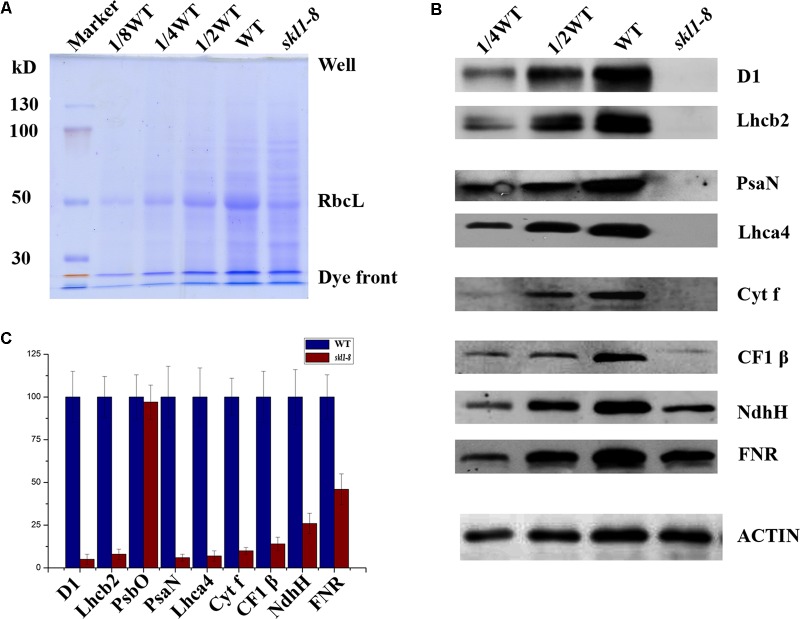
Accumulation of chloroplast proteins. (A) Coomassie brilliant blue staining of total proteins. Total protein resolved by SDS/PAGE from WT and skl1-8 and the major band of RbcL was indicated. (B) Western blot analysis of D1, Lhcb2, PsaN, Lhca4, Cyt f, CF1β, NdhH, FNR, and ACTIN in the total protein extract from wild-type and skl1-8 plants. These experiments were repeated three times independently, and similar results were obtained each time. Results from a representative experiment are shown. (C) The average signal intensities for each protein were quantified by the ImageJ software for three independent times, expressed level relative to the WT∗ (=100), and are indicated on the left.